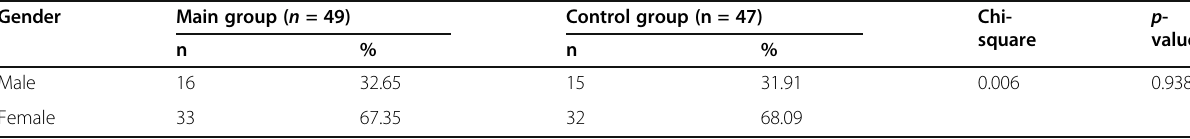
Table 2 Gender distribution of the